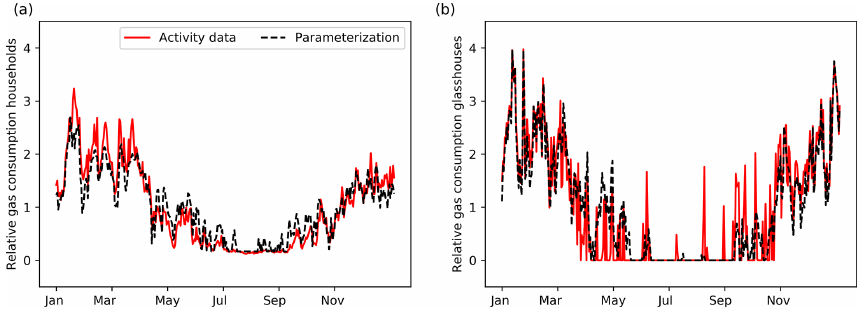
Figure 3. Daily time profiles for households (a) and glasshouses (b) . Solid red lines are based on true activity data, whereas dashed black lines are parameterizations based on the degree day function.